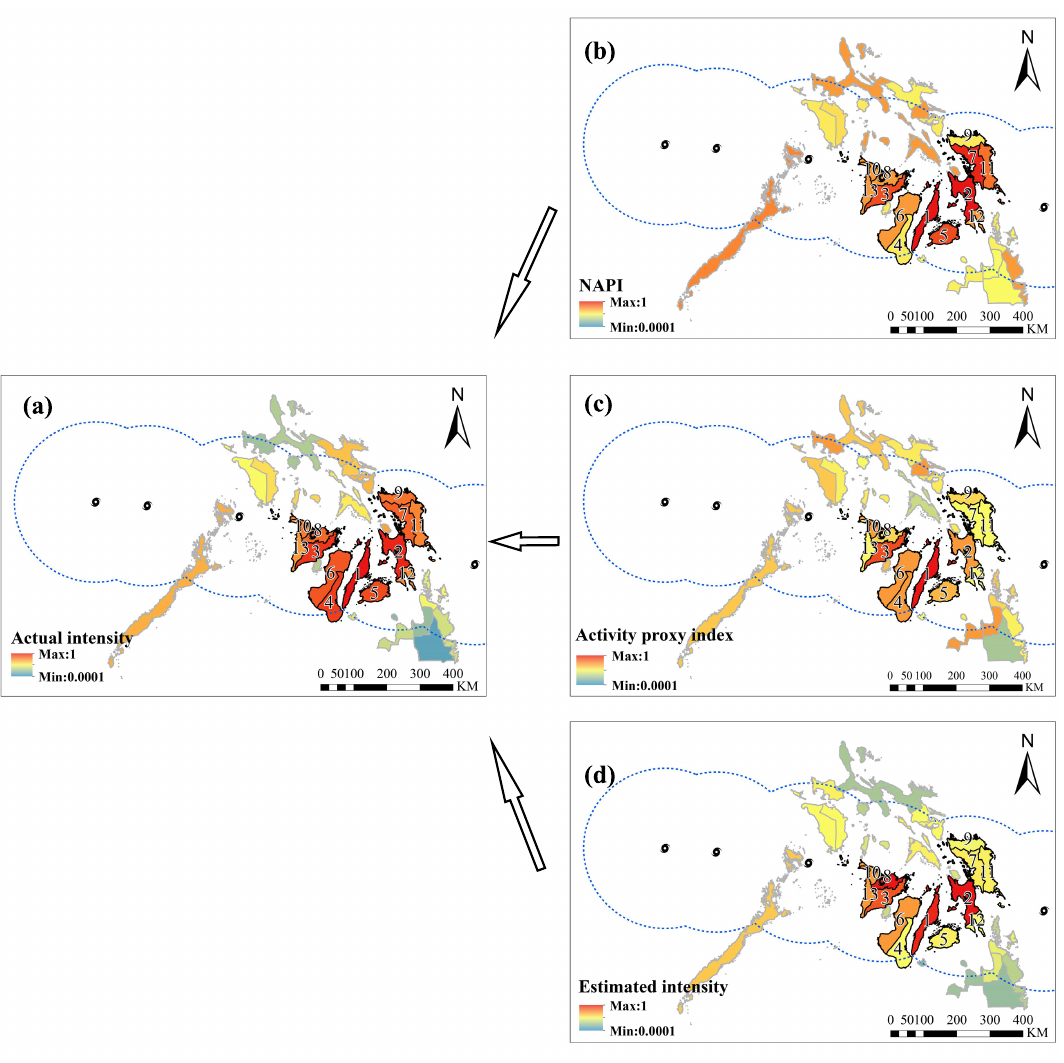
Figure 4. The affected population intensity due to Typhoon Haiyan. ( a ) The distribution of the actual intensity of the affected population and the estimated distribution of the intensity of the affected population resulting from ( b ) the normalized affected population index (NAPI), ( c ) the activity proxy index, and ( d ) the traditional population-density-based